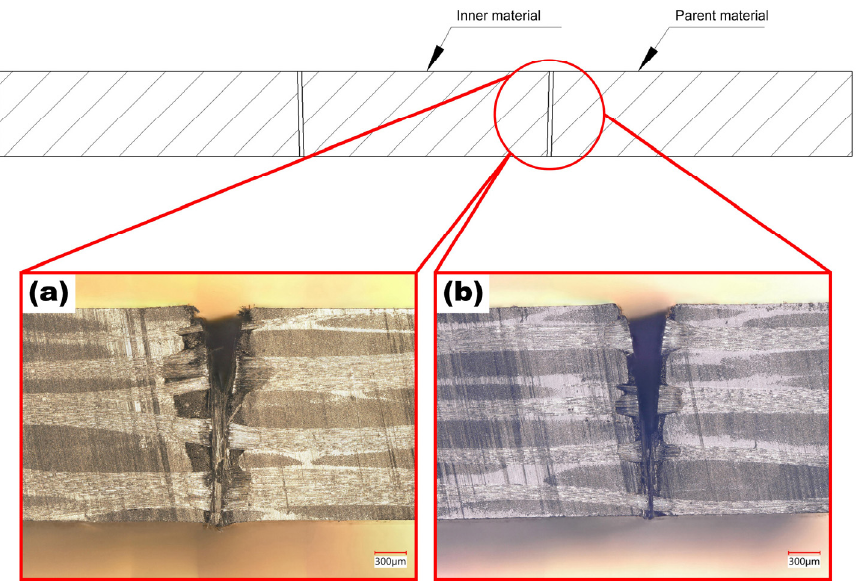
Figure 7. Comparison of cross sections for CFRP workpieces drilled via different methods: ( a ) stepped laser parameter multiple-ring drilling method; ( b ) constant laser parameter multiple-ring drilling method.